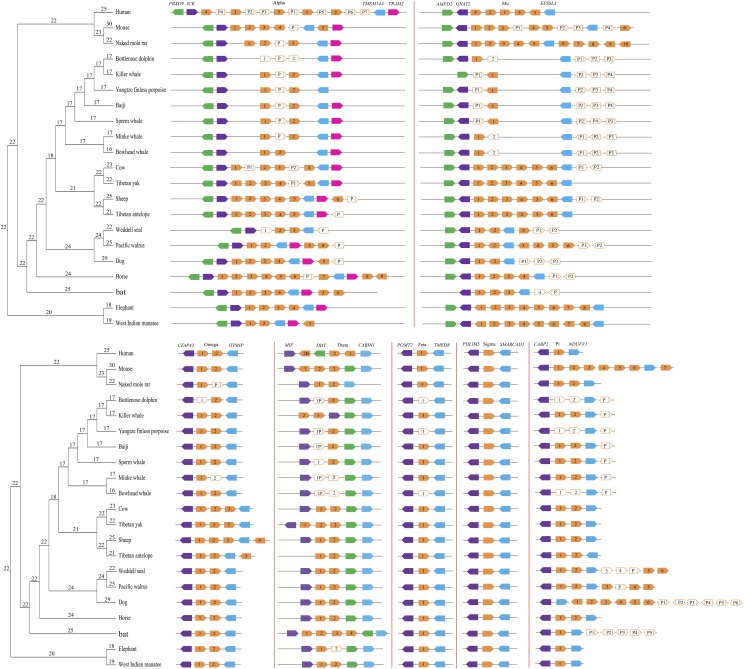
Genomic organization of GST genes in 21 mammalian species. The arrowed boxes represent genes and directions of transcription. GST genes are shown in orange, while flanking genes are indicated in green, purple, blue, and pink. Filled boxes: intact genes; empty boxes: partial gene, and empty boxes with a vertical line: pseudogenes (P). Connecting horizontal lines indicate genes on the same chromosome/genomic scaffold. Gene family sizes for ancestral states are shown along each node in the phylogenetic tree.